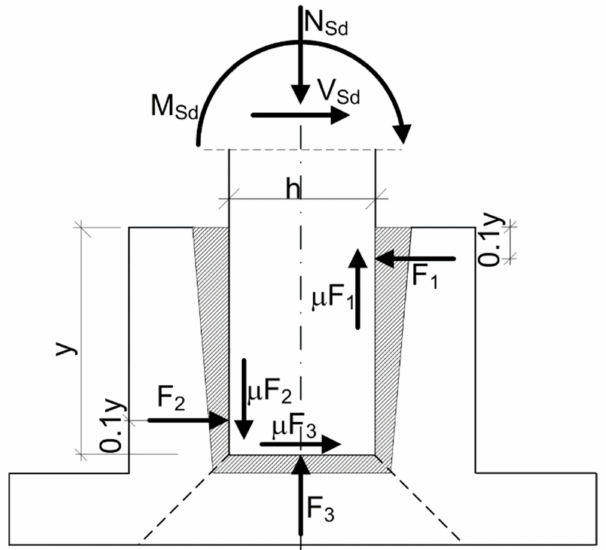
Figure 4. Computational model of PF according to